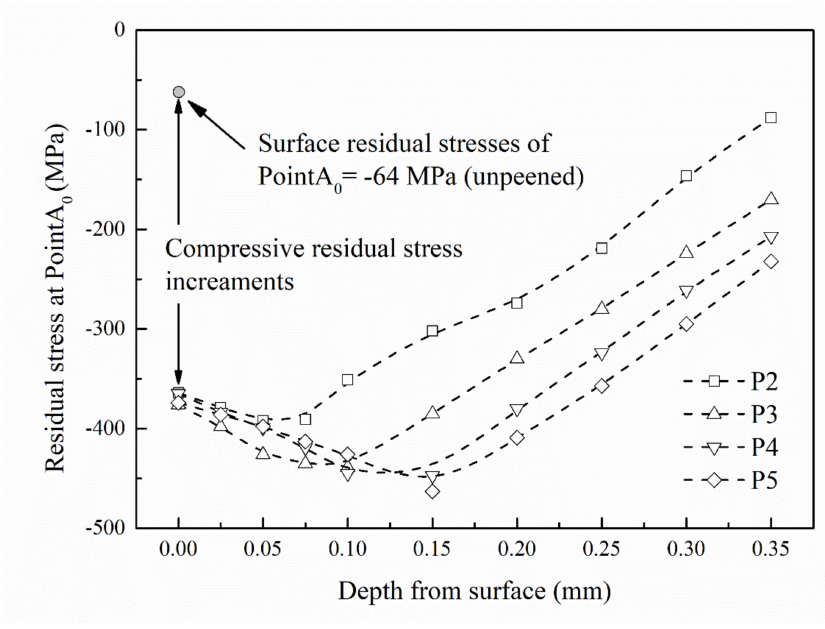
Figure 16. The compressive residual stress field in depth at PointA 0 of different specimens.